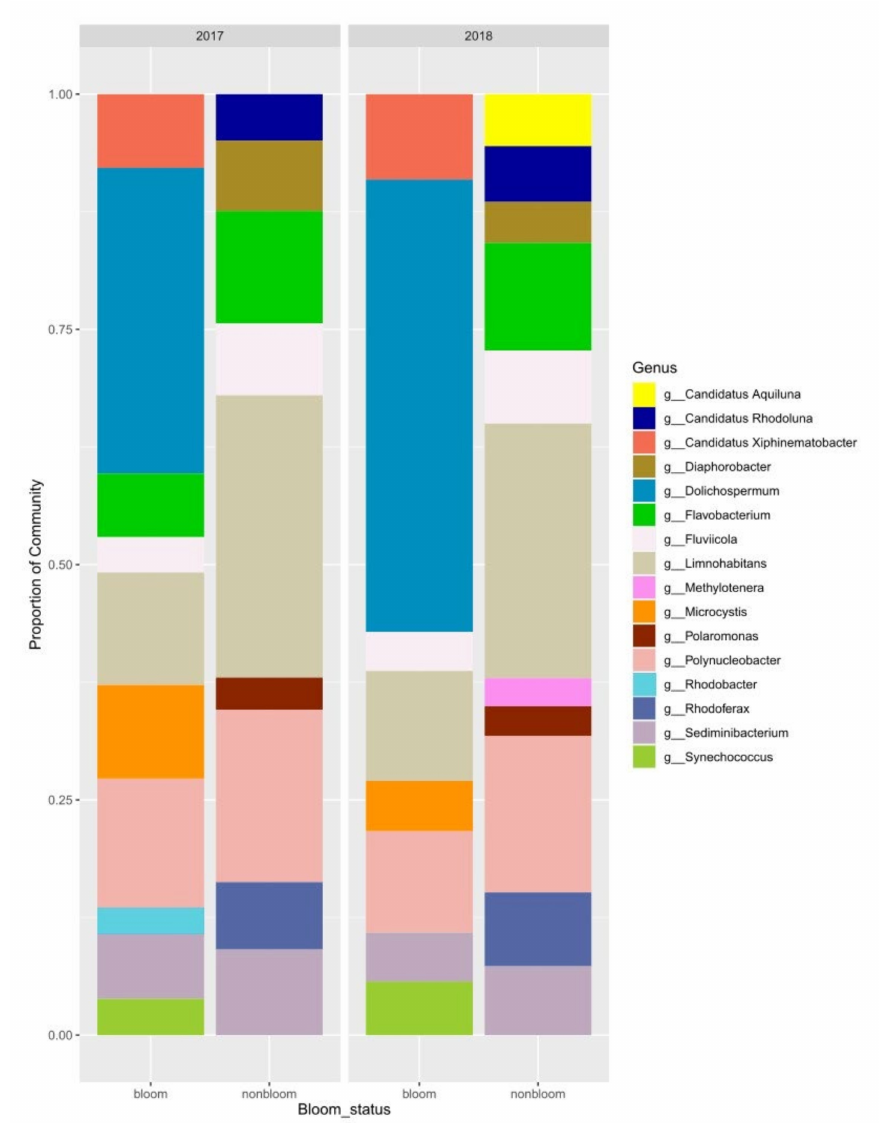
Figure 6. Dominant prokaryotic genera in bloom and non-bloom